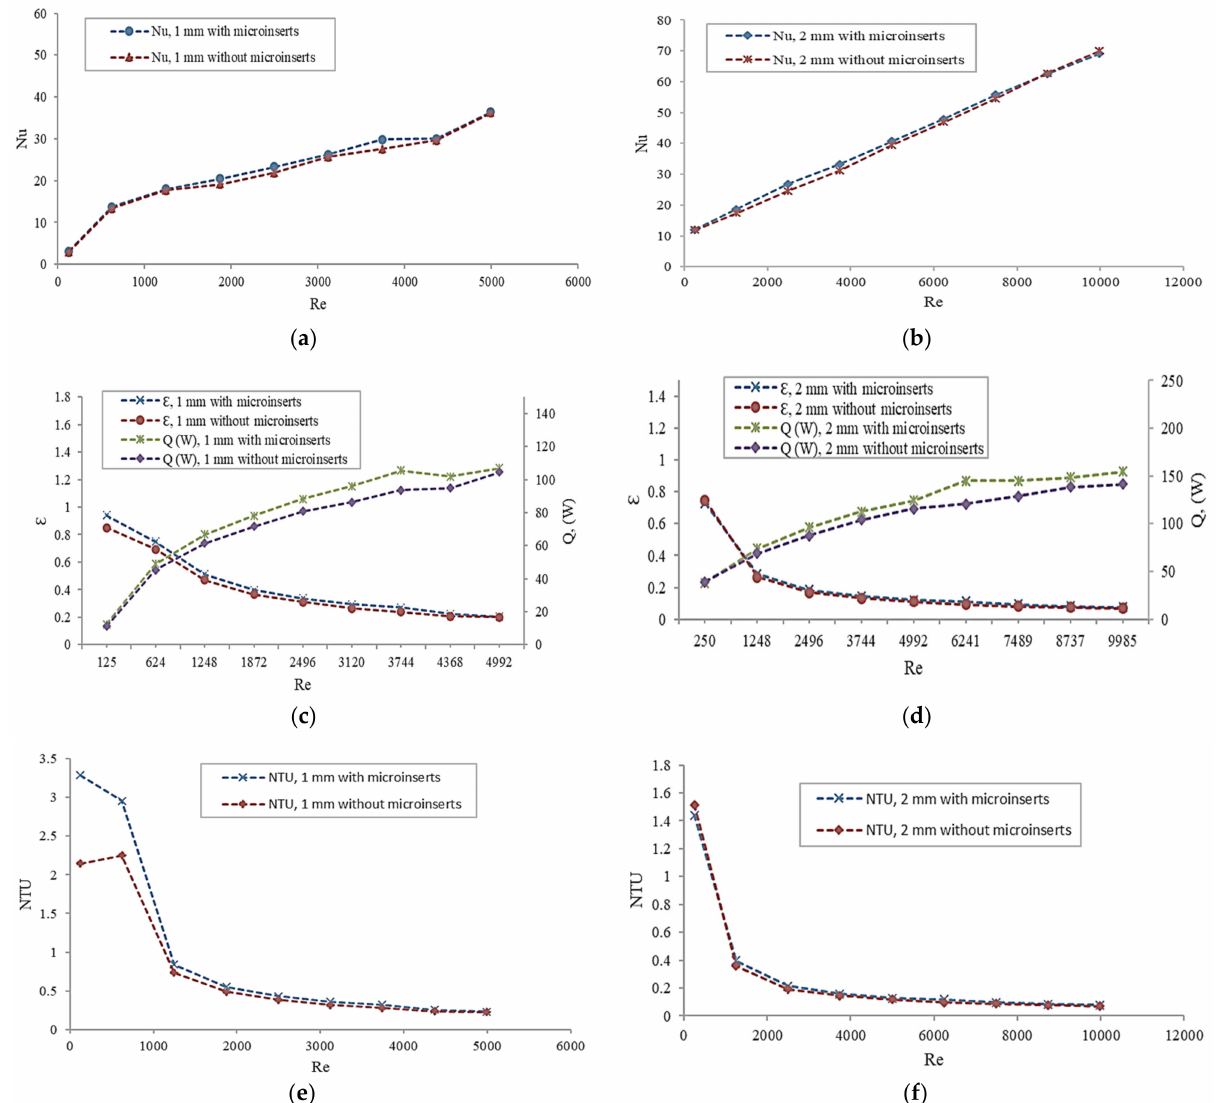
Figure 6. Variation in different thermal parameters with the Reynolds number.